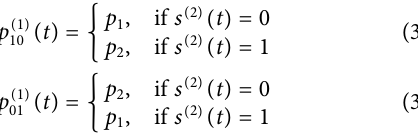
, β ϵ are parameters for the 1 2 and